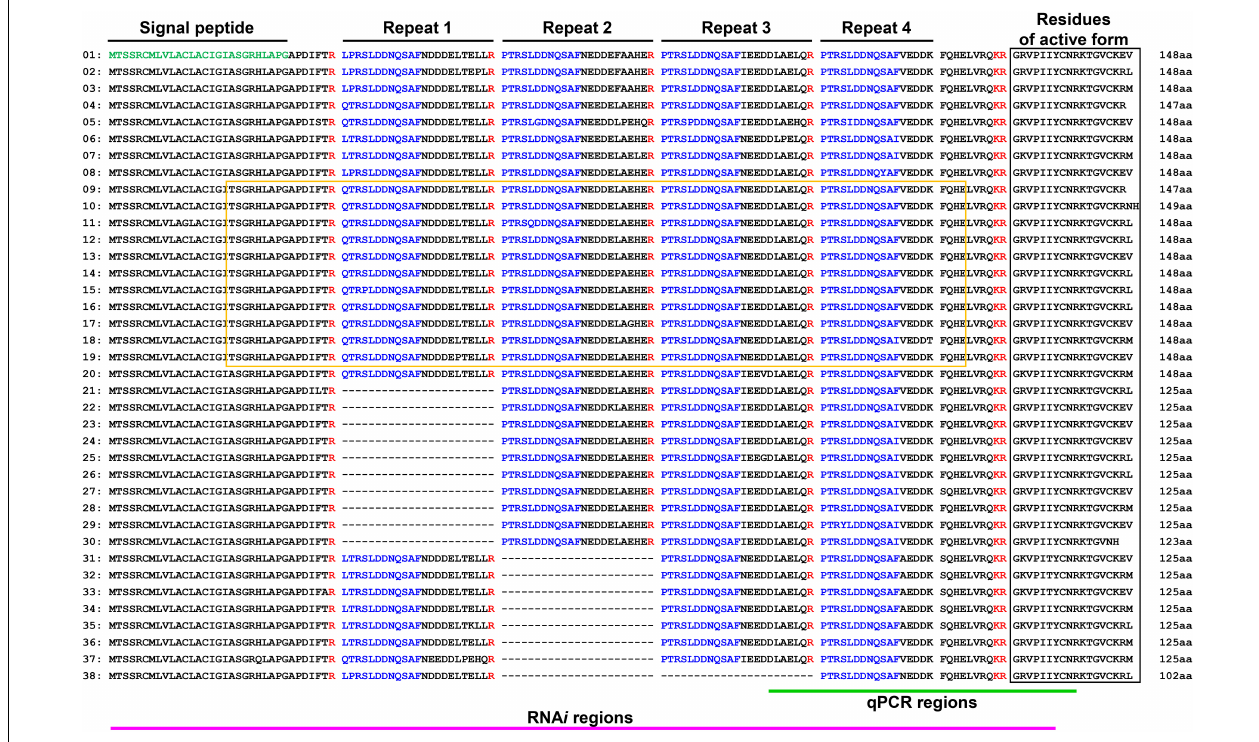
FIGURE 1 | Multiple precursor proteins of thanatin isoforms in R. pedestris . Structure analysis of precursor molecules (green: signal peptide region; blue: repetitive sequence). Black and yellow boxes indicate the region of antimicrobial activity and MACPF domain.